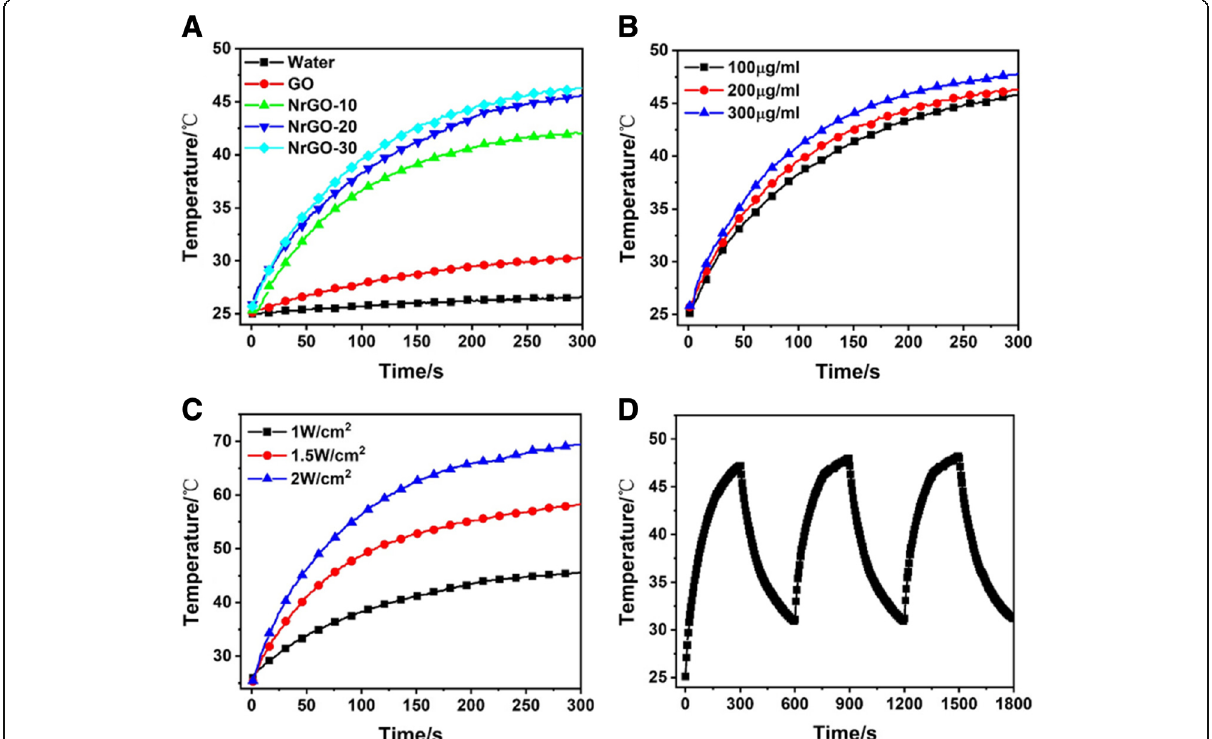
Fig. 7 Photothermal properties measurement. a Heating curves of water, GO, and NrGO samples (200 μ g/ml) under 808 nm laser irradiation (1 W/cm 2 ). b Heating curves of NrGO-30 with different concentrations under 808 nm laser irradiation (1 W/cm 2 ). c Heating curves of NrGO-30 (200 μ g/ml) under 808 nm laser irradiation at different power density. d Temperature change curve of NrGO-30 (200 μ g/ml) under 808 nm laser irradiation for cycle irradiation of three times (1 W/cm 2